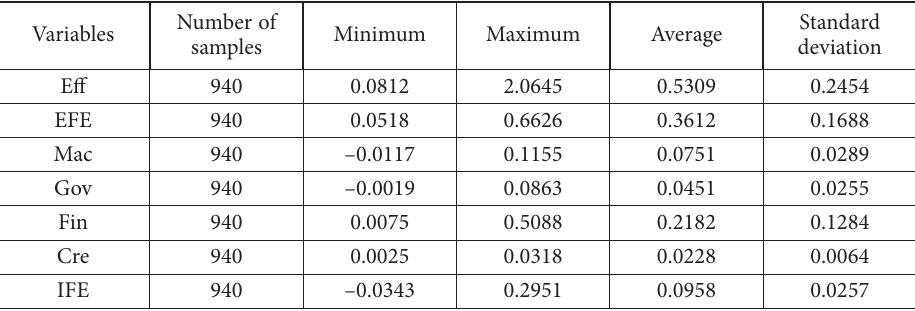
Table 7. Descriptive statistics of main